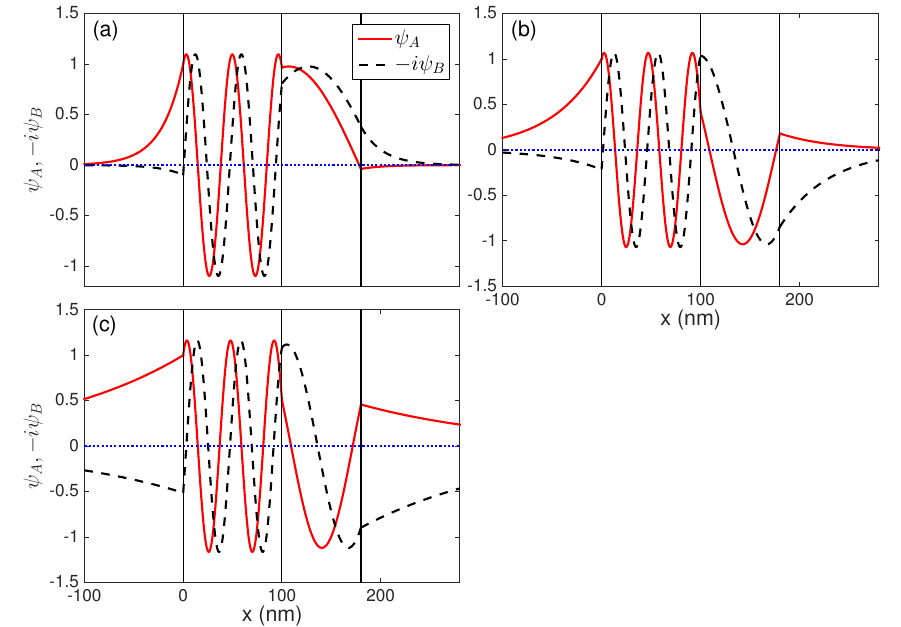
Figure 8. The wave function Ψ A (solid) and − i Ψ B (dashed) of guided modes as a function of distance corresponding to the intersections in Figure 7a: ( a ) k 2 x h 1 = 13.4848, θ = 19.0890 o ; ( b ) k 2 x h 1 = 14.0965, θ = 8.9296 o ; and ( c ) k 2 x h 1 = 14.2552, θ = 4.5134 o